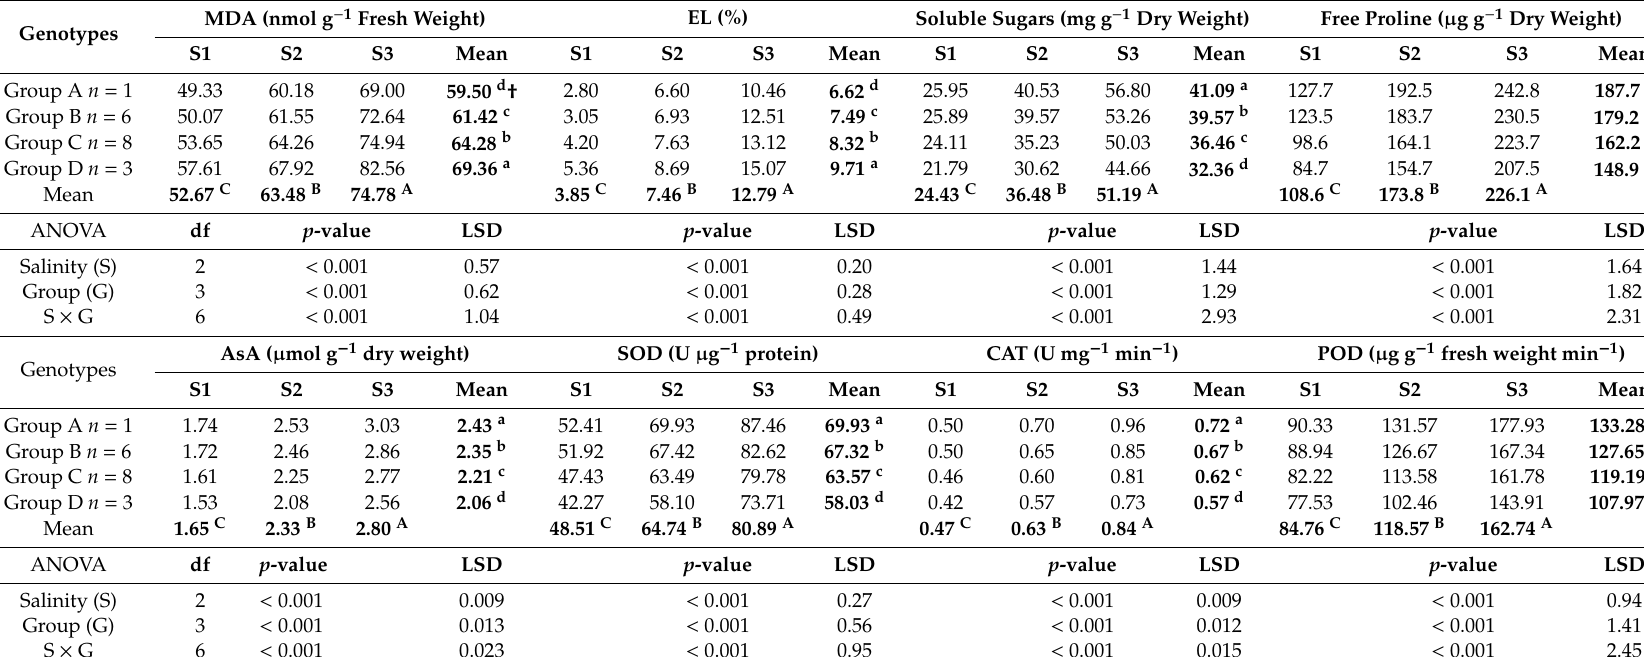
Table 3. Impact of di ff erent salinity levels on malondialdehyde (MDA), electrolyte leakage (EL), total soluble sugars content, free proline content, ascorbic acid (AsA), superoxide dismutase (SOD), catalase (CAT), and peroxidase (POD) of four genotype groups classified according to salinity tolerance under three salinity levels of